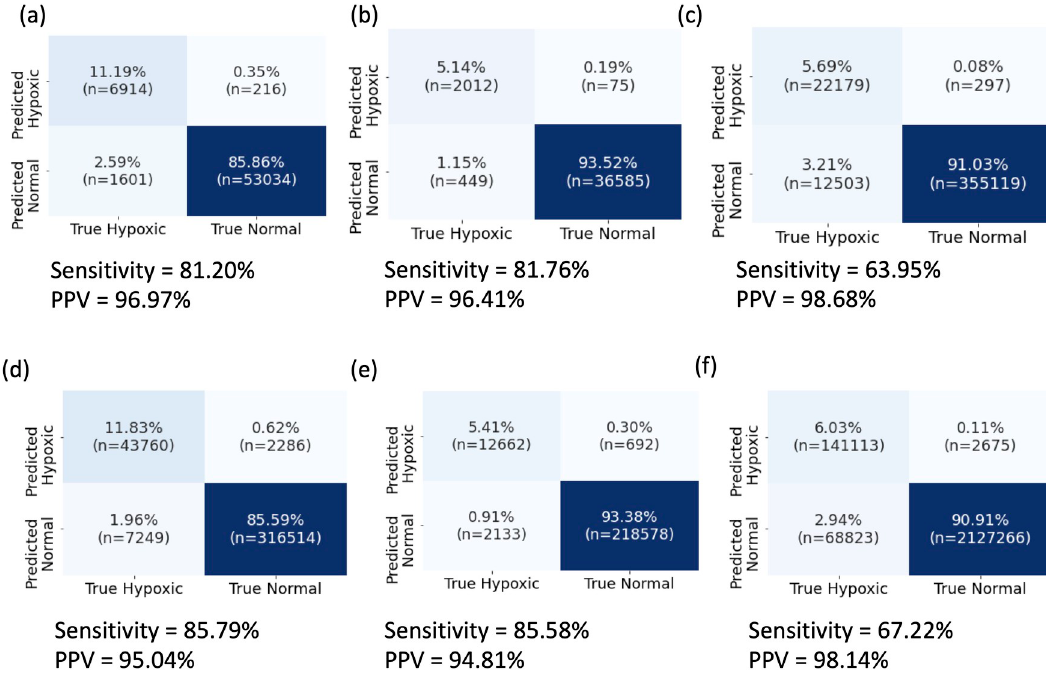
Fig 3. Confusion matrices aggregated across all timepoints for all patients for (a) eICU Ventilator– 30 minute, (b) eICU No ventilator– 30 minute, (c) JH-CROWN– 30 minute, (d) eICU Ventilator– 5 minute, (e) eICU No ventilator– 5 minute, (f) JH-CROWN– 5